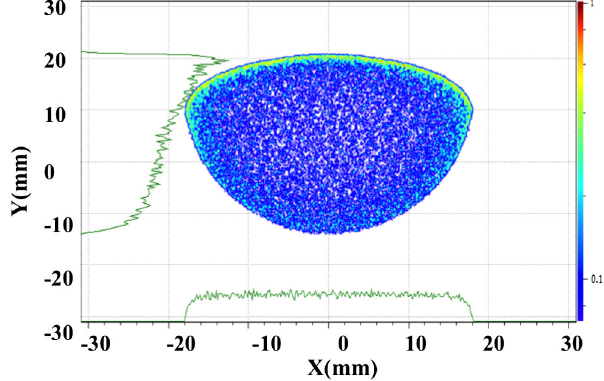
FIG. 12. Beam distribution generated by the extraction system simulation used as input for the Linac4 LEBT simulations.